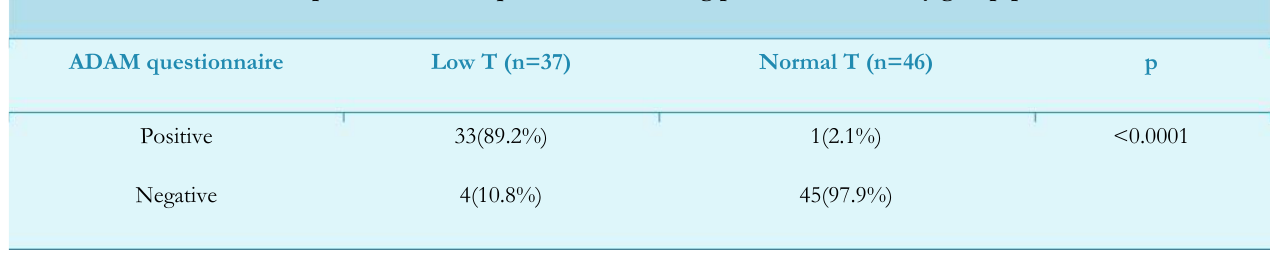
Table 5: Distribution of microvascular complications